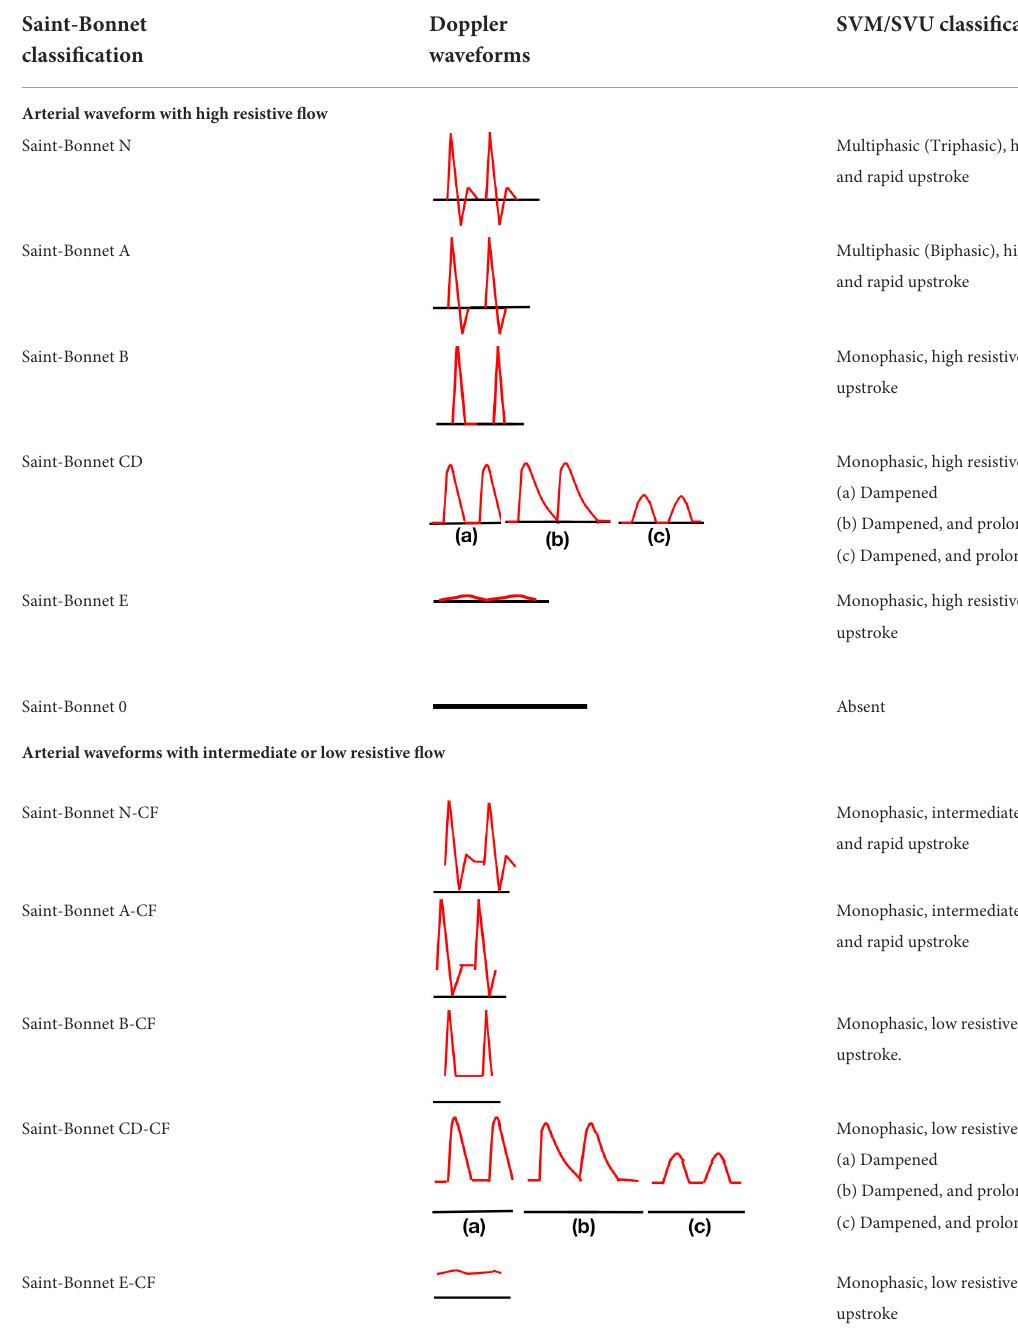
TABLE 1 Equivalence between Saint-Bonnet classification and SVM/SVU